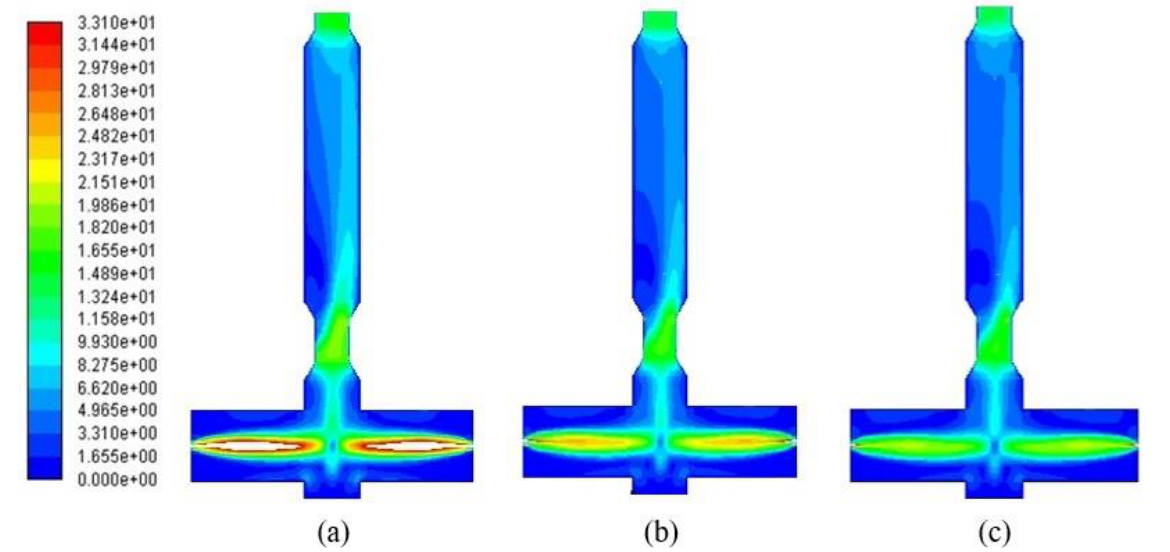
Figure 9. Comparison of velocity (m/s) distribution along the central plane for ( a ) 50% O 2 , ( b ) 75% O 2 , and ( c ) 95% O 2 .